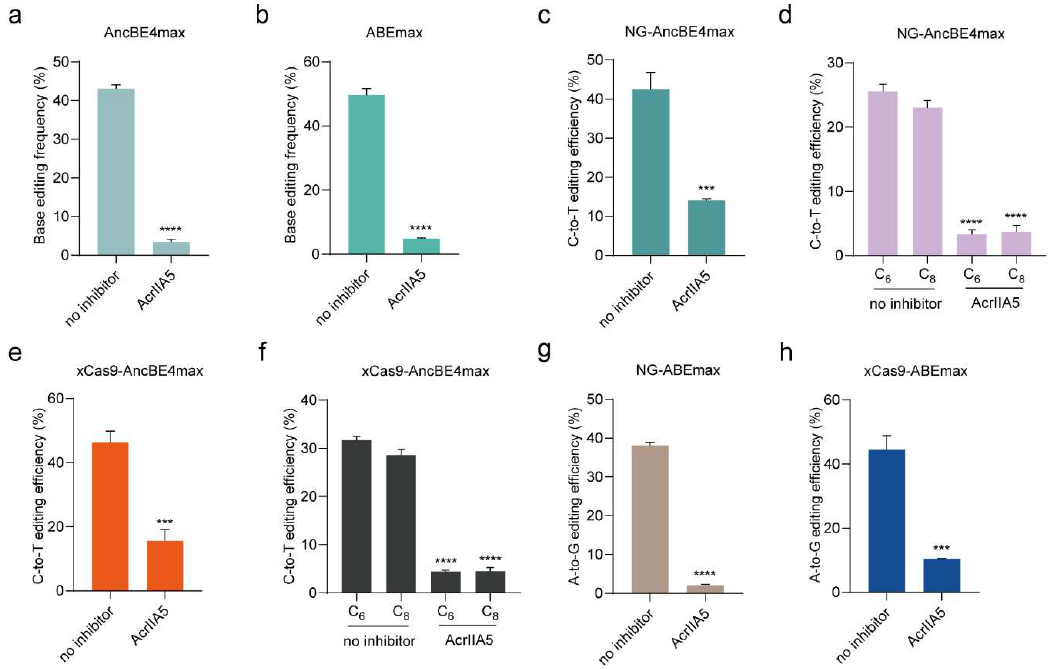
Figure 3. AcrIIA5 inhibits base editor variants in human cells. ( a , b ) AcrIIA5 was tested for its ability to inhibit AncBE4max at site 5 and ABEmax at site 9. ( c – f ) AcrIIA5 was tested for its ability to